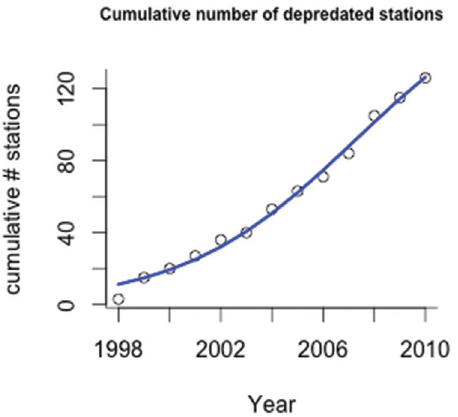
Figure 2. The cumulative number of stations with depredation over time with best fitting function (logistic).